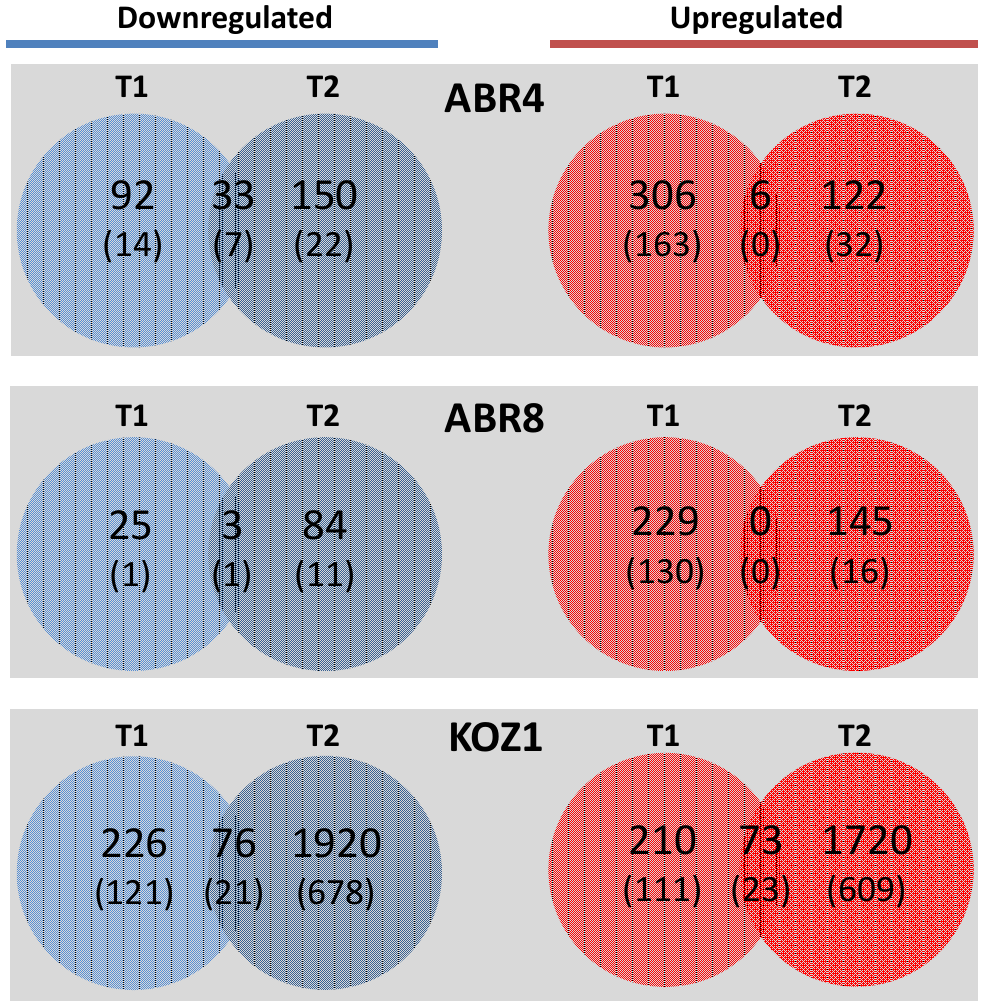
Figure 1. Venn diagram depicting the number of differentially expressed genes (DEGs) in the three Brachypodium distachyon genotypes (ABR4, ABR8 and KOZ1) in response to drought stress after 4 days (T1) and 8 days (T2) of witholding water. For each time point the number of genes with > 2-fold change in expression is shown with the number of genes with >4-fold change in brackets.